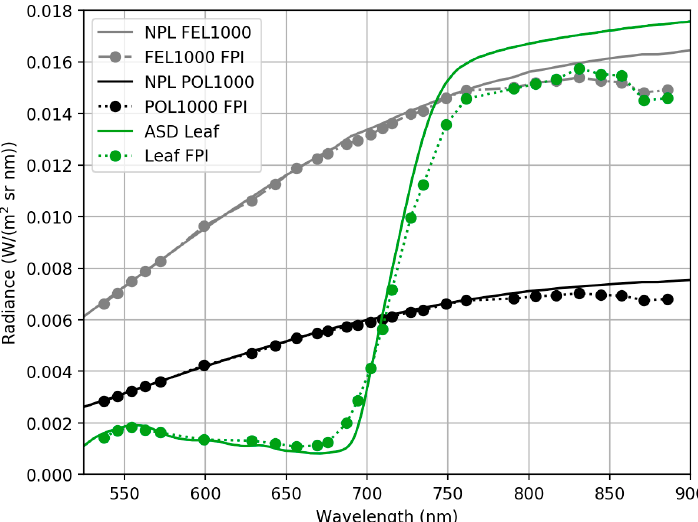
Figure 9. Original radiance spectra and same spectra integrated with FPI spectral responses. NPL FEL1000 and NPL POL1000: reference spectra provided by NPL; FEL1000 FPI and POL1000 FPI: corresponding spectra sampled using the FPI camera spectral responses; ASD Leaf: leaf radiance spectra measured using the ASD at the FGI’s laboratory; Leaf FPI: the ASD spectra sampled using the FPI-camera spectral responses. Leaf FPI is same as Leaf ASD line in Figure 7a.